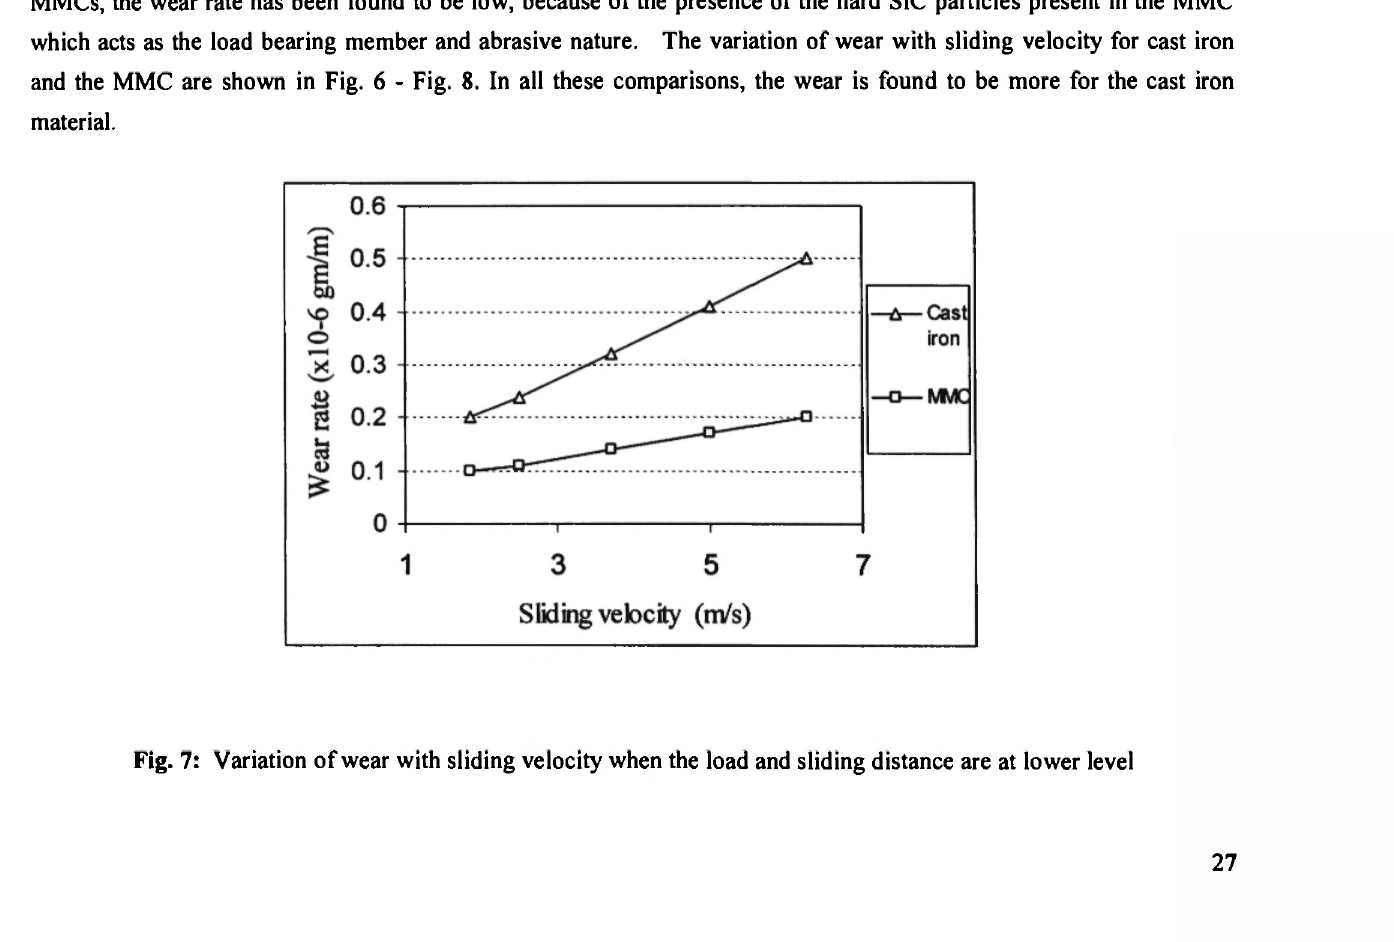
Wear comparison of Cast iron and MMC